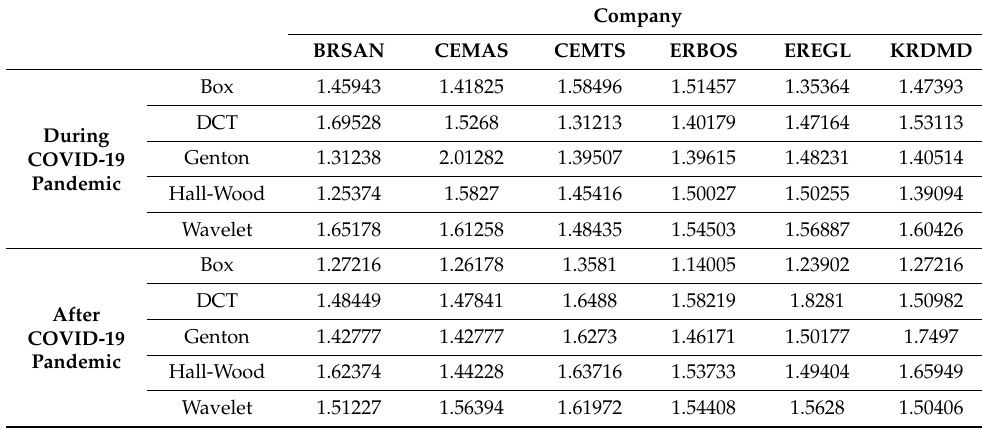
Table A4. Fractal dimensions for the metal industry